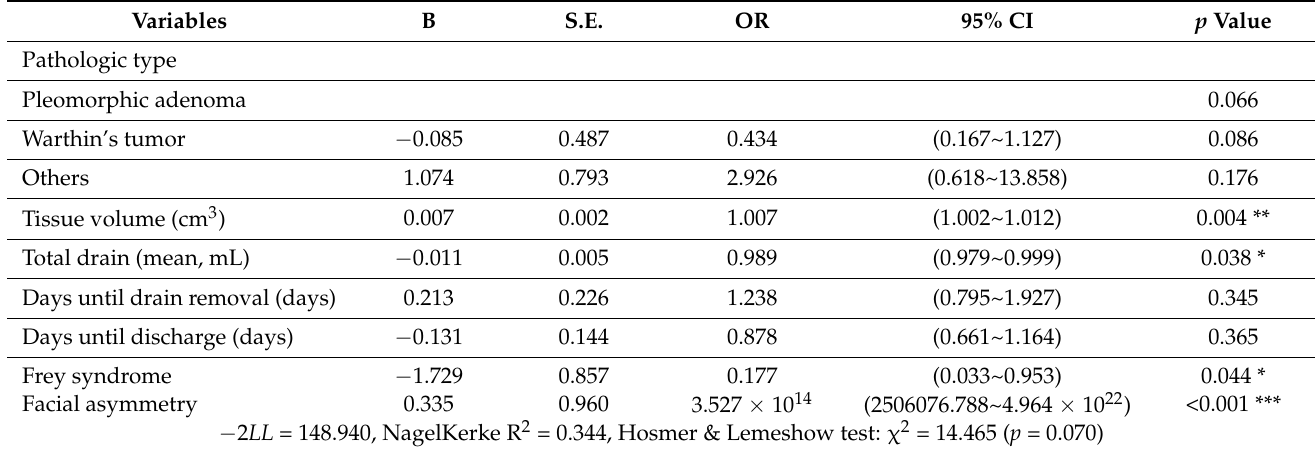
Table 4. Multivariate logistic regression model for drain amount and day until drain removal.